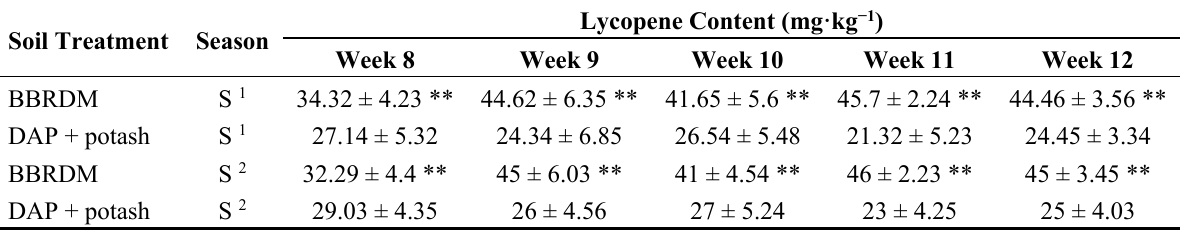
Table 1. Lycopene contents of tomatoes grown with BBRDM and DAP +